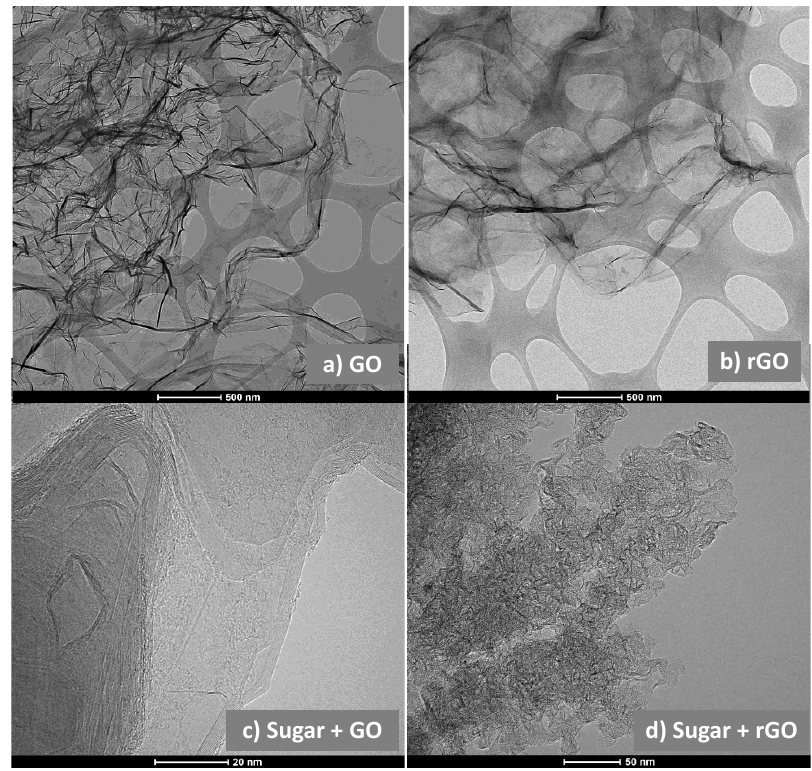
Figure 2. ( a ) GO and ( b ) rGO heat treated by themselves; compared to their respective composites nanostructures with sugar—( c ) sugar + GO and ( d ) sugar + rGO.